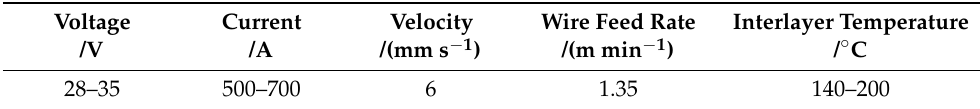
Table 2. Additive manufacturing parameters for preparing high-strength low-alloy steel T-branch pipe via SAAM.